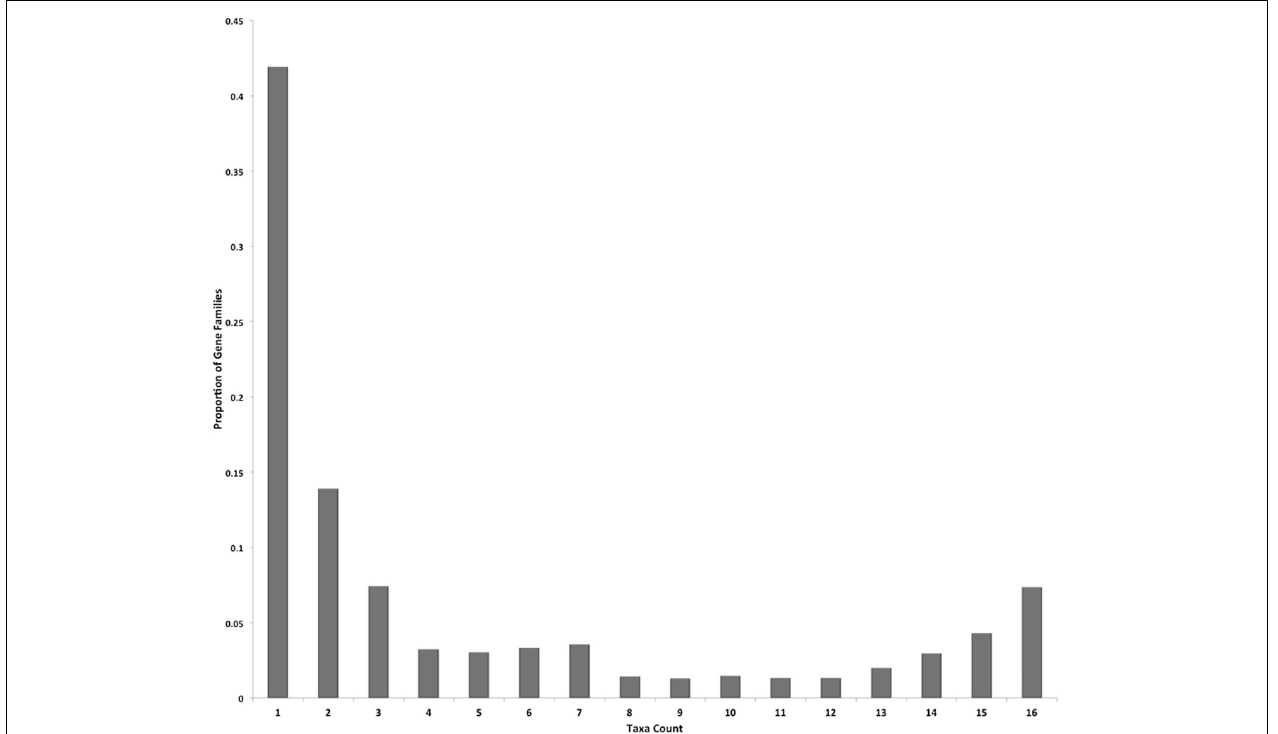
FIGURE 1 | Gene families are predominantly species-specific in the sampled taxa. The proportions of gene families with proteins encoded in one through 16 fungal taxa genomes (taxa count) are displayed for the 19,489 OrthoMCL gene families.